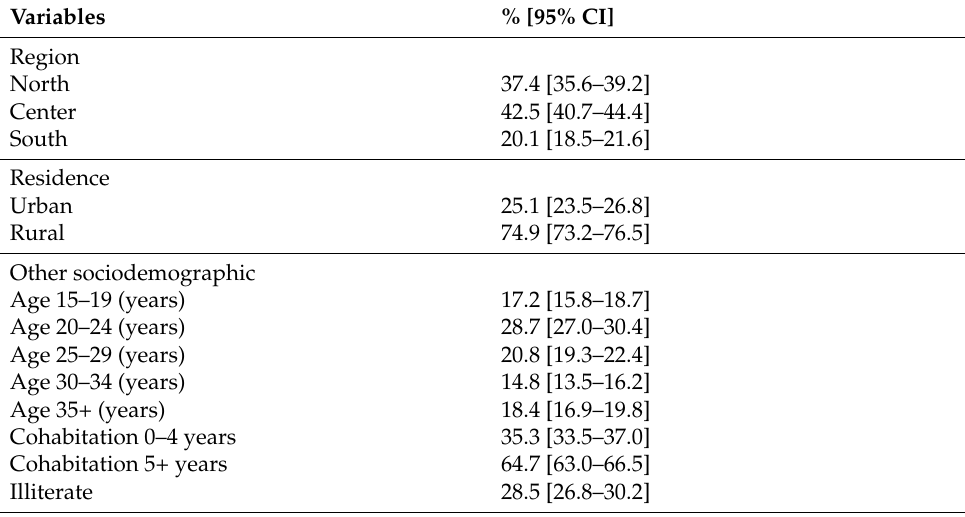
Table 1. Women’s sociodemographic and health